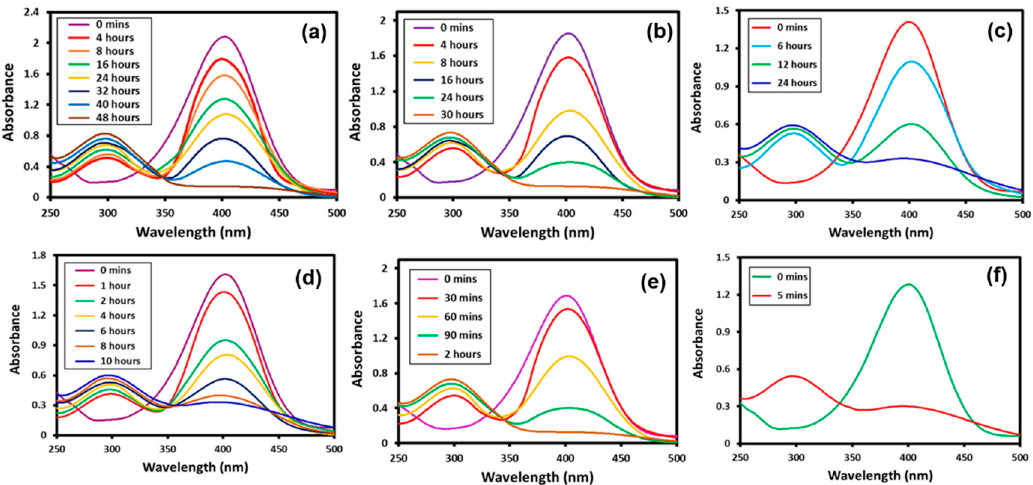
Figure 6. UV–Vis spectra showing the catalytic reduction of 4-nitrophenol using Au, Ag, and Au–Ag alloy NPs: ( a – c ) results of catalytic reduction of 4-NPh to 4-APh with Ag, Au, and Au–Ag NPs